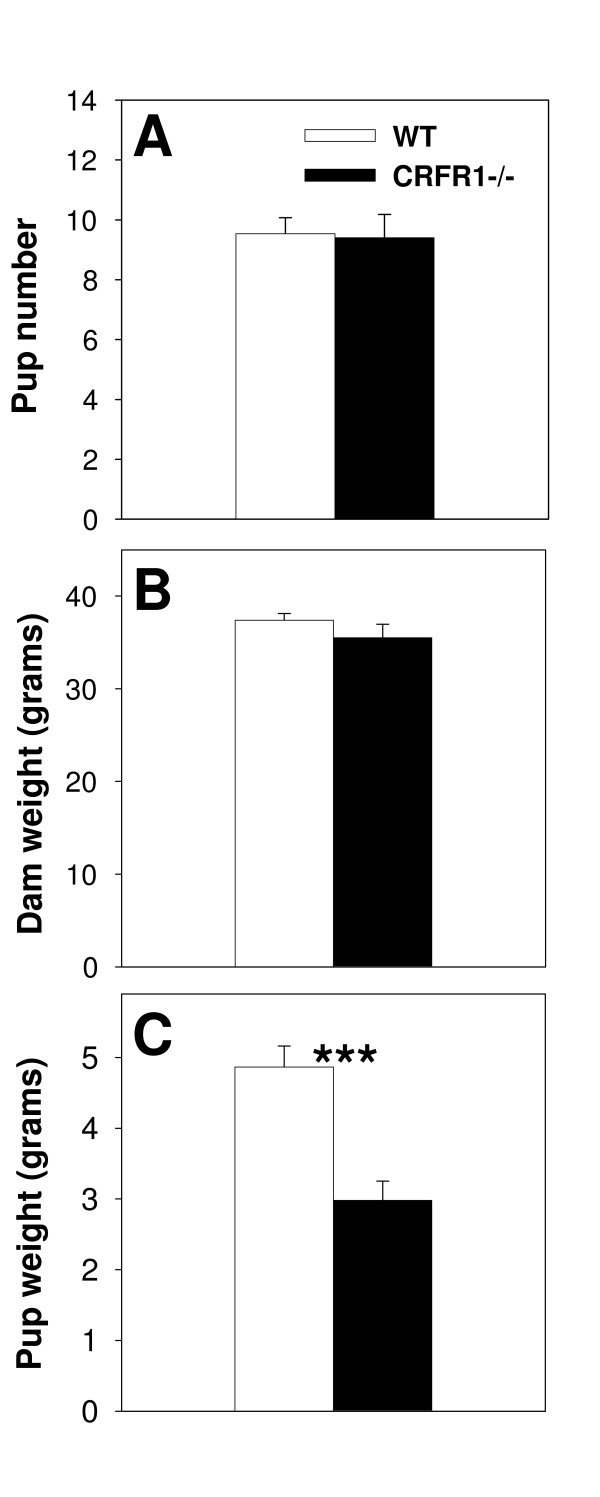
Profile of WT and CRFR1-/- dams and pups. Neither pup number (A) nor dam weight (B) differed between genotype. In contrast, mean pup weight on postpartum Day 6 was significantly higher in WT relative to CRFR1-/- mice (C). Bars represent means ± SE. White bars indicate WT mice and black bars indicate CRFR1-/- mice. *** = p < 0.001; one-way ANOVA.